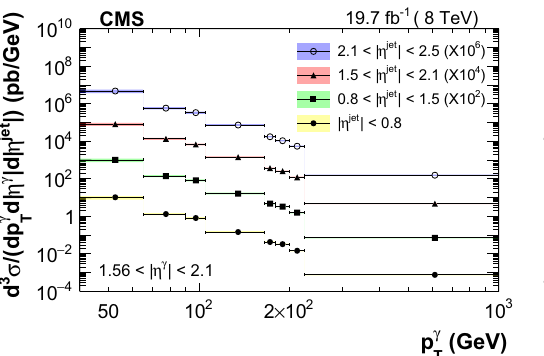
Fig. 3 Measured triple-differential cross section distributions as a γ function of p in different bins of | η jet | for photons in the barrel region. T Note that the distributions are multiplied by a factor of 10 2 , 10 4 and